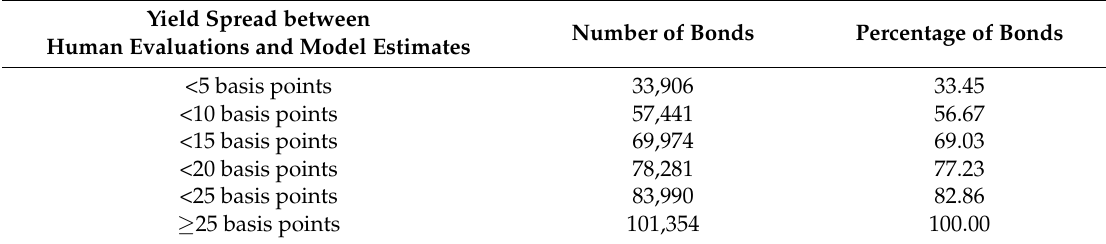
Table 4. Comparison between human evaluations and model